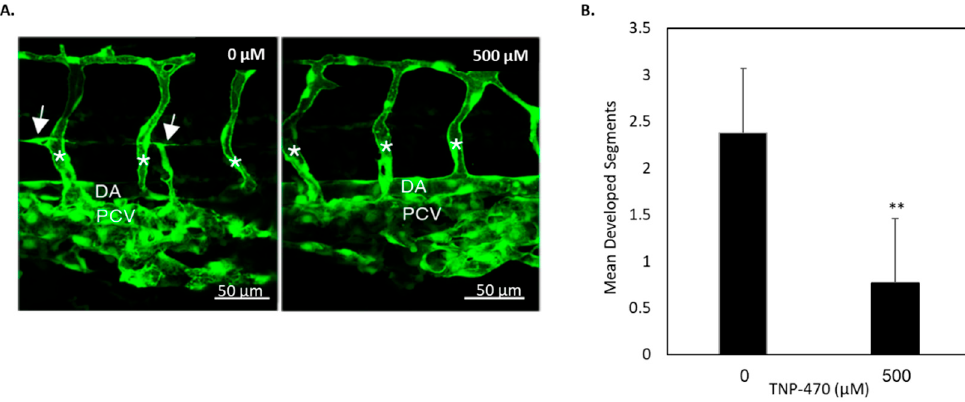
Figure 6. Reduction in the lymphatic vasculature in TNP-470-treated zebrafish embryos carrying the fli1:EGFP y1 transgene. ( A ) Zebrafish treated with 500 µM of TNP-470 showed a reduced lymphatic vasculature (right) when compared with untreated zebrafish (left). Images were acquired using a Zeiss LSM700 confocal microscope and an Axio Imager M2 compound microscope. ( B ) Statistical analysis of the presence of lymphatic vessels of the treated and untreated groups. DA, dorsal aorta; PCV, posterior cardinal vein. Asterisks mark ISVs, and arrows point at PACs. n = 17. ** P < 0.01. The results are presented as mean ± SEM. Scale bar = 50 µm.